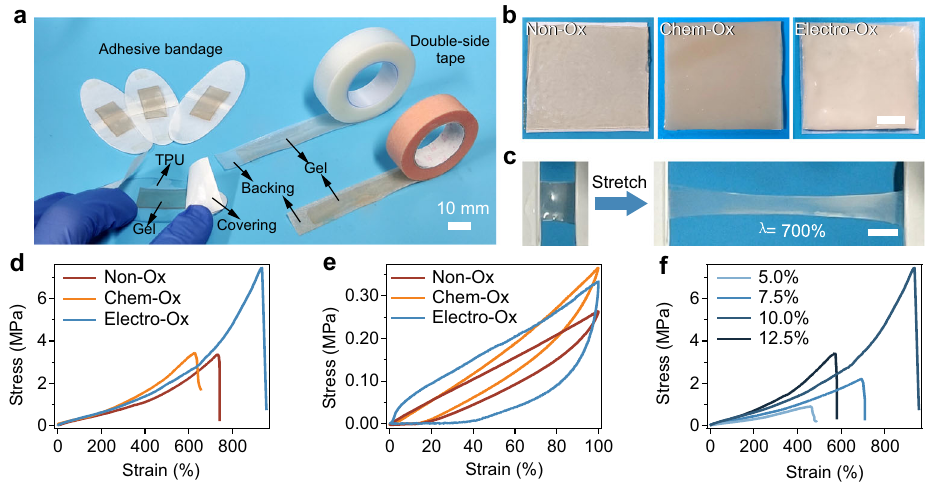
Fig. 2 Mechanical properties of the adhesive hydrogel tapes based on electro-oxidized alginate-dopa. a Adhesive bandages and double-side tapes made of Electro-Ox hydrogels. b Images of the Non-Ox, Chem-Ox, and Electro-Ox hydrogel tapes on white patches. Scale bar = 10 mm. c Images of the Electro- Ox hydrogel tape stretched to more than seven times the original length. Scale bar = 10 mm. d Typical tensile stress – strain curves of the Non-Ox, Electro- Ox and Chem-Ox hydrogel tapes at an alginate-dopa concentration of 10 w/v%. e Typical stretch – relaxation curves of Non-Ox, Chem-Ox, and Electro-Ox hydrogel tapes. f Typical tensile stress – strain curves of Electro-Ox hydrogel tapes at various mass concentrations of electro-oxidized alginate-dopa (5.0, 7.5, 10.0, and 12.5